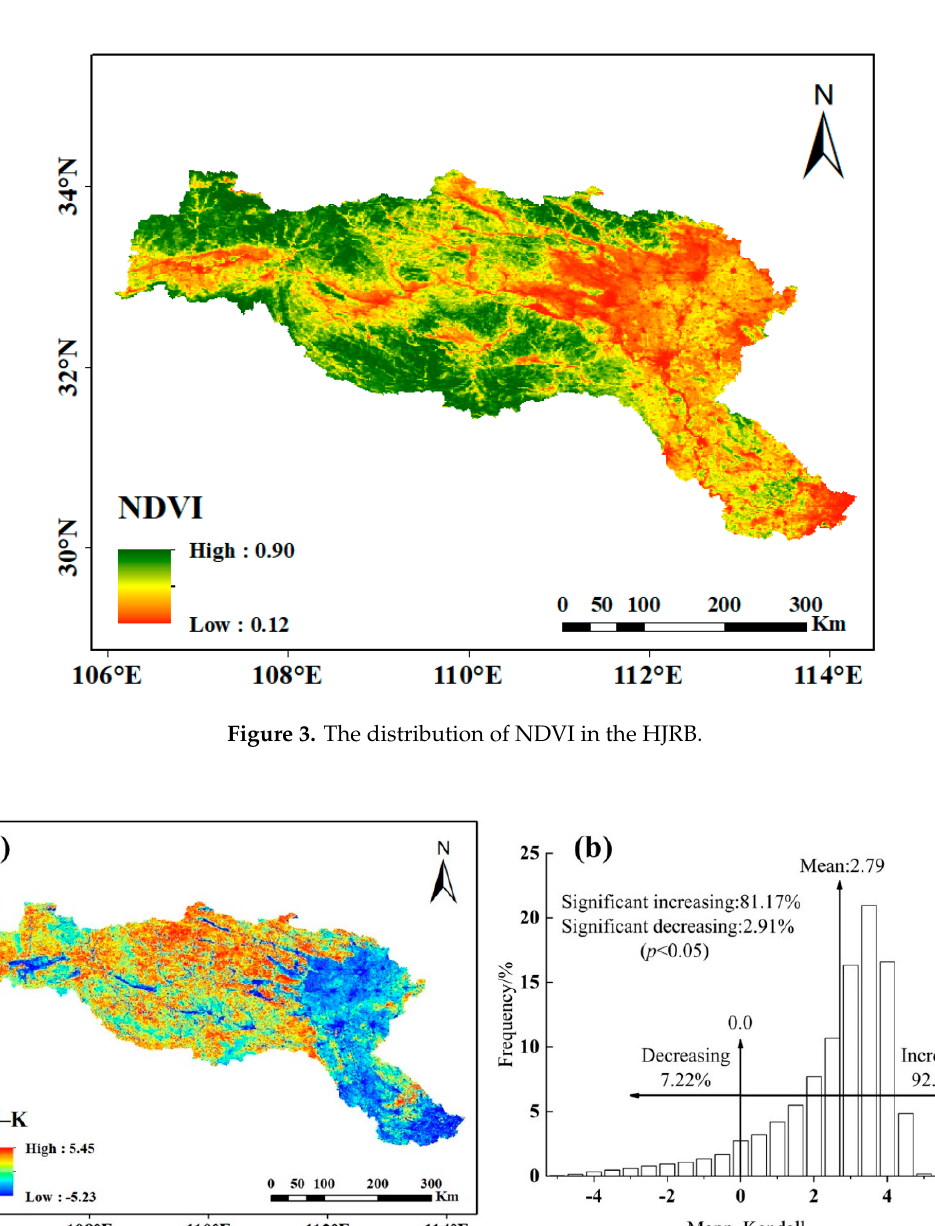
Table 4. The PD values of each factor.